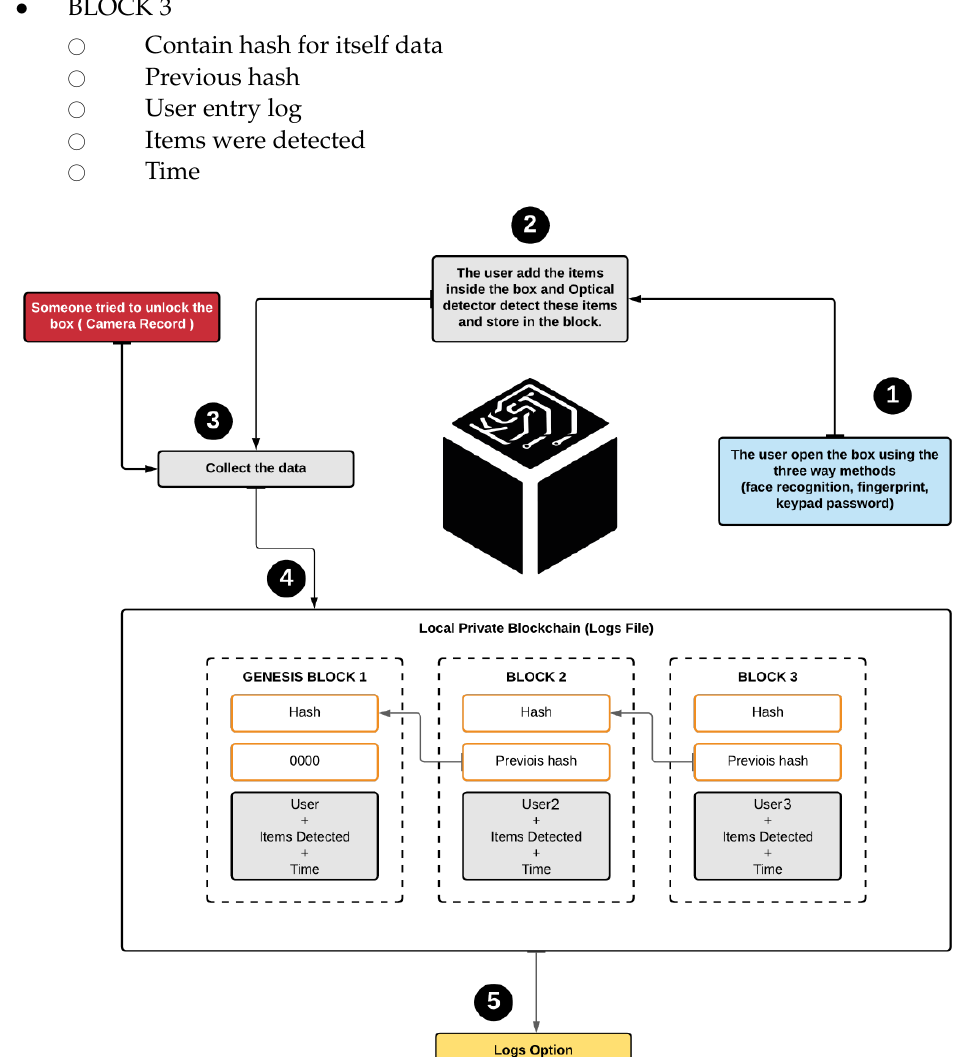
Figure 1. Private